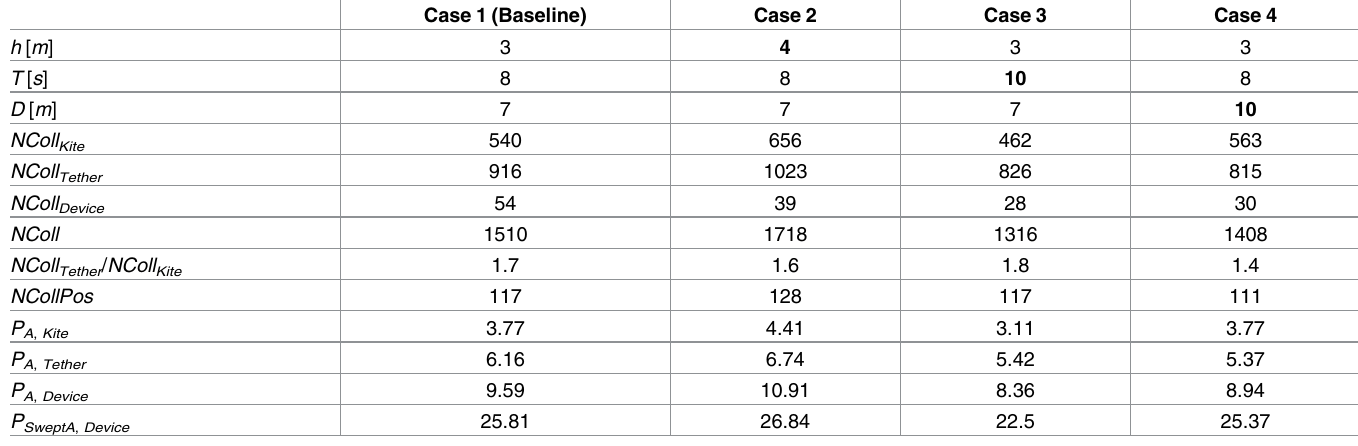
Table 3. Case 2: Variation of kite trajectory Fig 2.2 shows results for a case with h = 4 m . With the kite flying a higher figure of eight, no col- lisions occur with the kite in a small region off the centre, around y = ±2 − ±3. The main Table 3. Number of collisions NColl and probabilities P as defined in the text above for varying configurations, based on 15750 simulations. The parameter changedfrom the baselinecase is set in